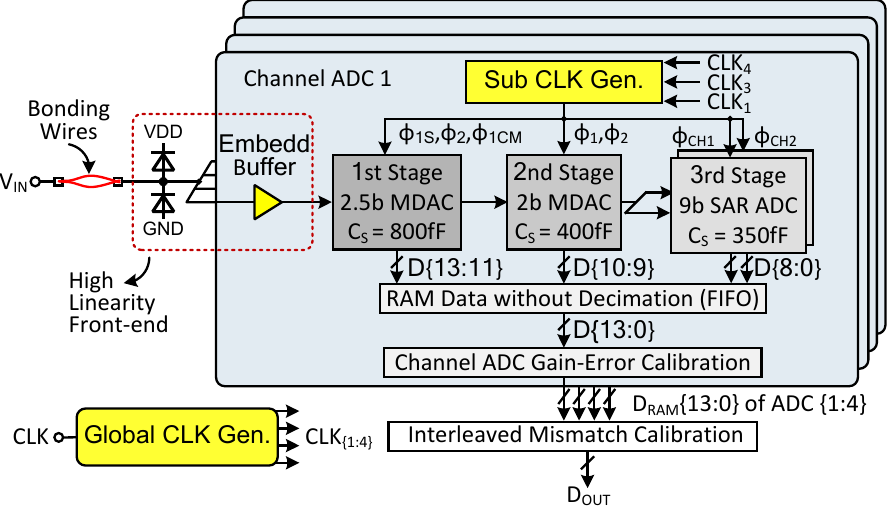
Figure 5. Top-level 2.5 GS/s 12-b four-way TI-ADC architecture (single-ended, actually differential). The symmetrical differential input and clock routing structure is shown in Figure 6.